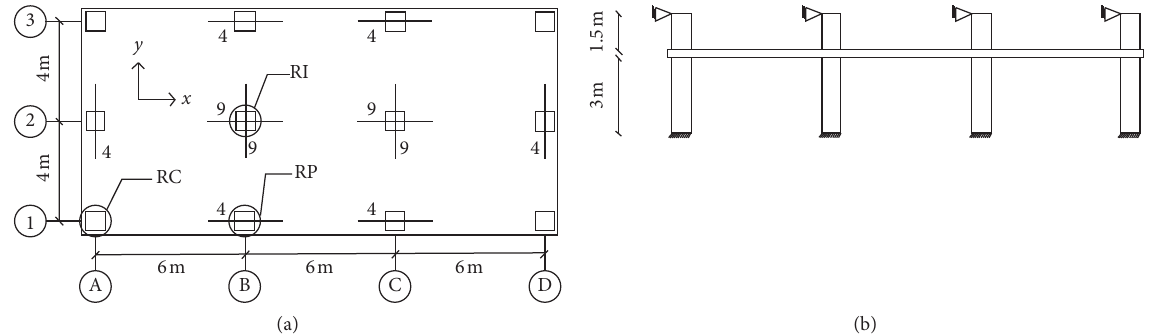
Figure 1: Schematic representation of number of 10mm add bars at the upper reinforcement layer of the case study floor (a) and a side view of the plan in parallel to x -axis